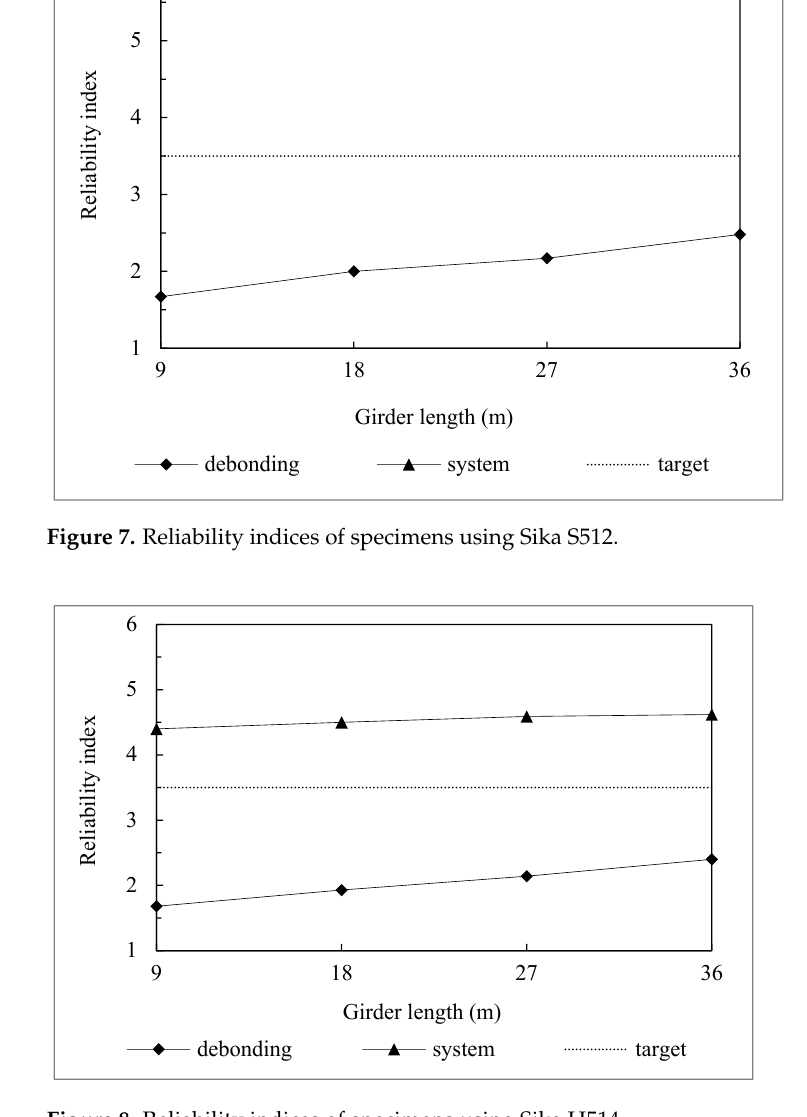
Figure 8. Reliability indices of specimens using Sika H514.